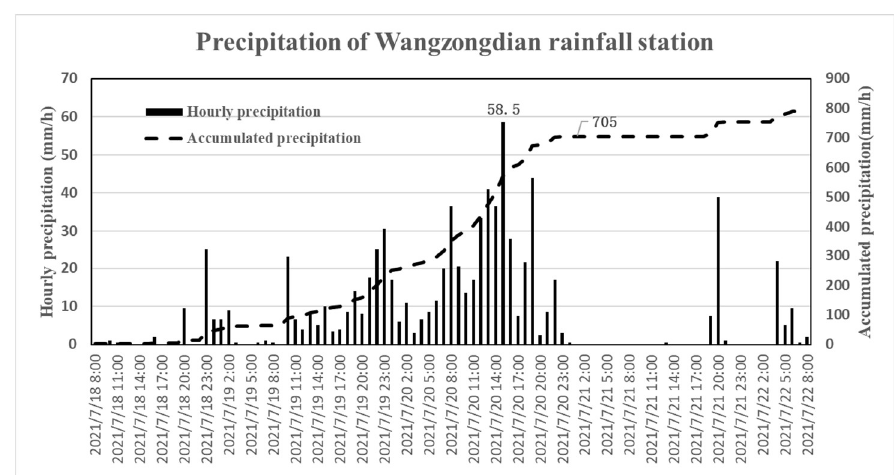
Figure 5. Cumulative and hourly rainfall distribution of Wangzongdian Rainfall Station.